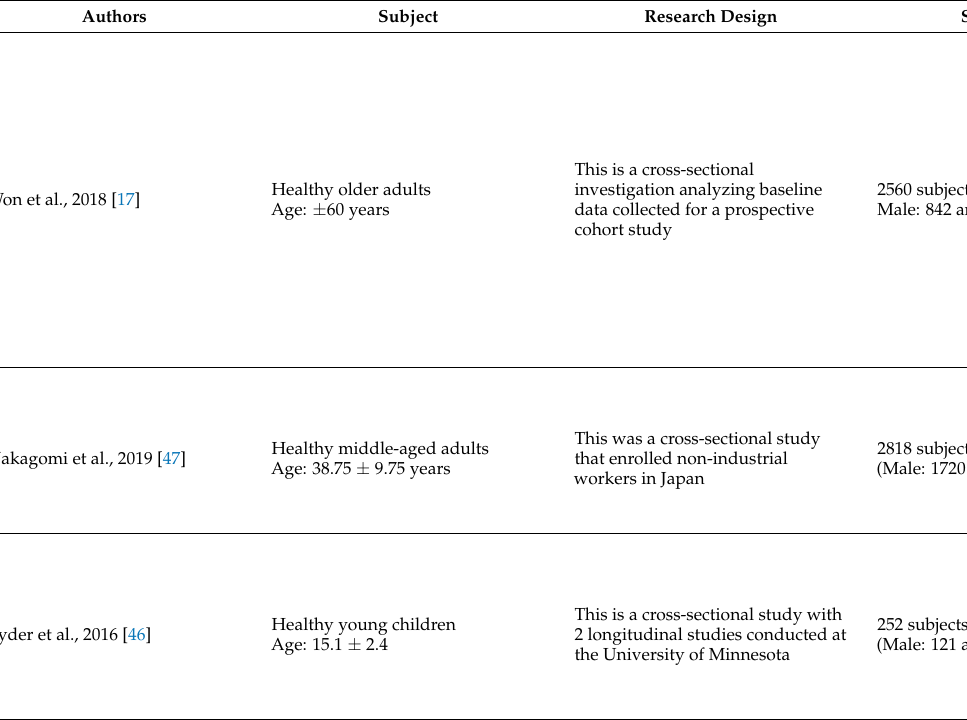
Table 1. Summary of the associations between metabolic impairments and arterial